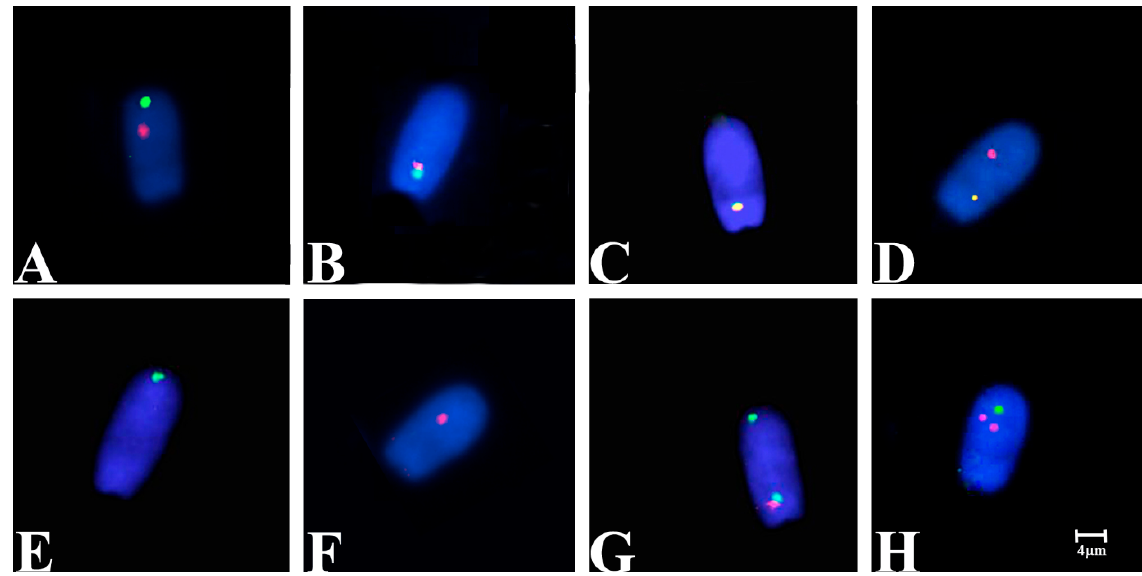
Figure 2. Representative spermatozoa heads after FISH analysis with 1st ( Ssc 15) and 2nd ( Ssc 17) pools stained in G (green) and R (red), respectively. ( A ) Alternate normal sperm nucleus with separate G and R signals. ( B , C ) rob(15;17)-carrier sperm nucleus with attacked G and R or Y (overlapped) signals. ( D ) Adjacent I sperm nucleus with R and Y signals. ( E ) Adjacent I sperm nucleus with G signal. ( F ) Adjacent II sperm nucleus with R signal. ( G ) Adjacent II sperm nucleus with G and RG signals. ( H ) A 3:1 sperm nucleus with double R and single G signals.